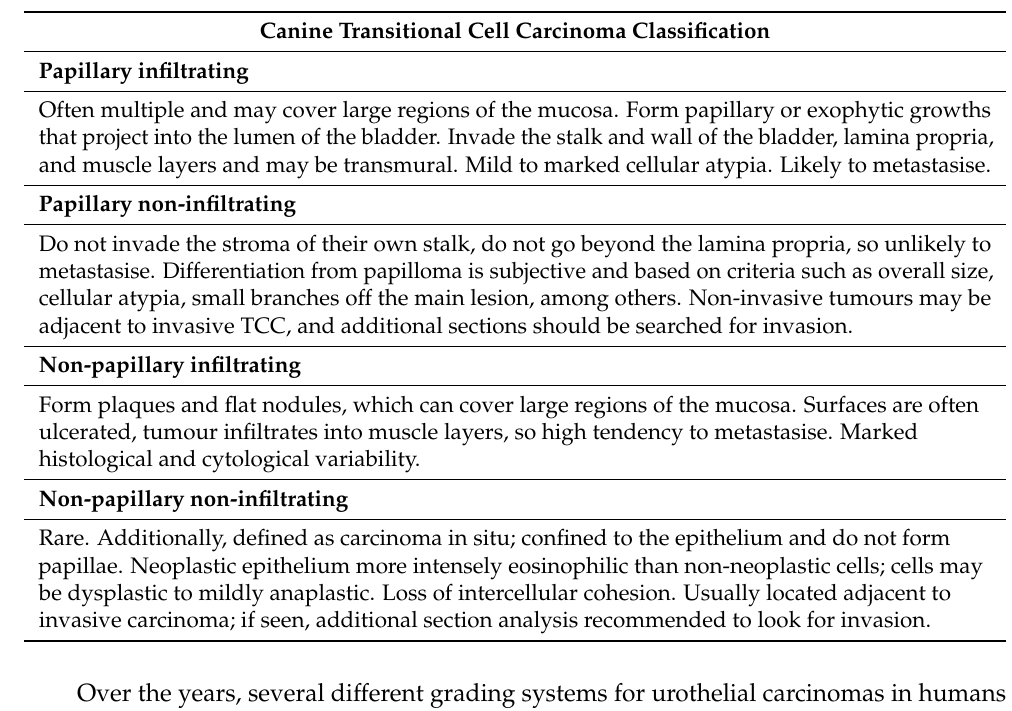
Table 2. Classification of canine TCC subtypes based on growth pattern (adapted from Meuten and Meuten, 2016